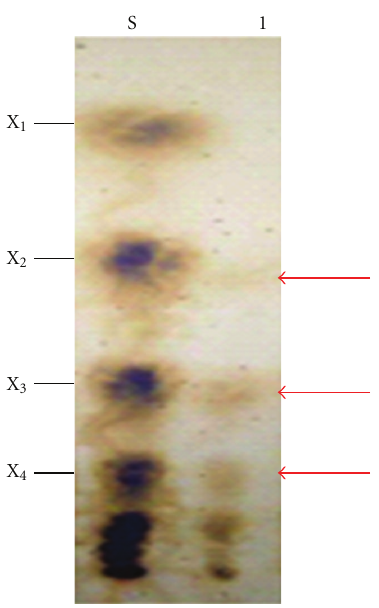
Figure 6: TLC analysis for hydrolysis products released from birch- wood xylan by xylanase from Bacillus arseniciselenatis DSM 15340. S: substrate; 1: sample; X 1 : D-xylose; X 2 : xylobiose; X 3 : xylotriose; X 4 : xylotetraose.